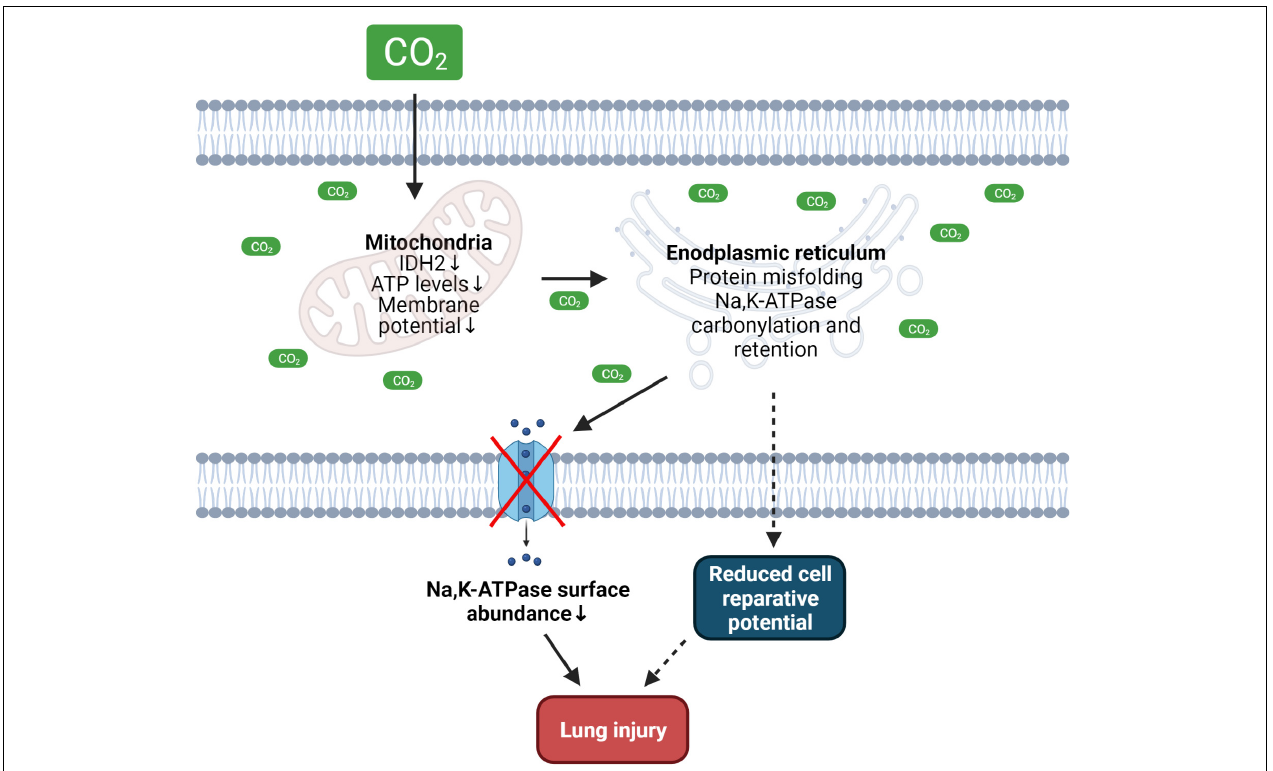
FIGURE 1 | Effects of hypercapnia on mitochondrial and ER function driving lung injury. Increased CO 2 levels cause mitochondrial dysfunction, reduce intracellular ATP levels thus altering ER function and promoting misfolding of the Na,K-ATPase protein leading to decreased plasma membrane abundance of the transporter. Hypercapnia-induced dysfunction of the mitochondria and ER may reduce cell reparative potential thus contributing to lung injury. IDH2, isocitrate dehydrogenase 2. Created with